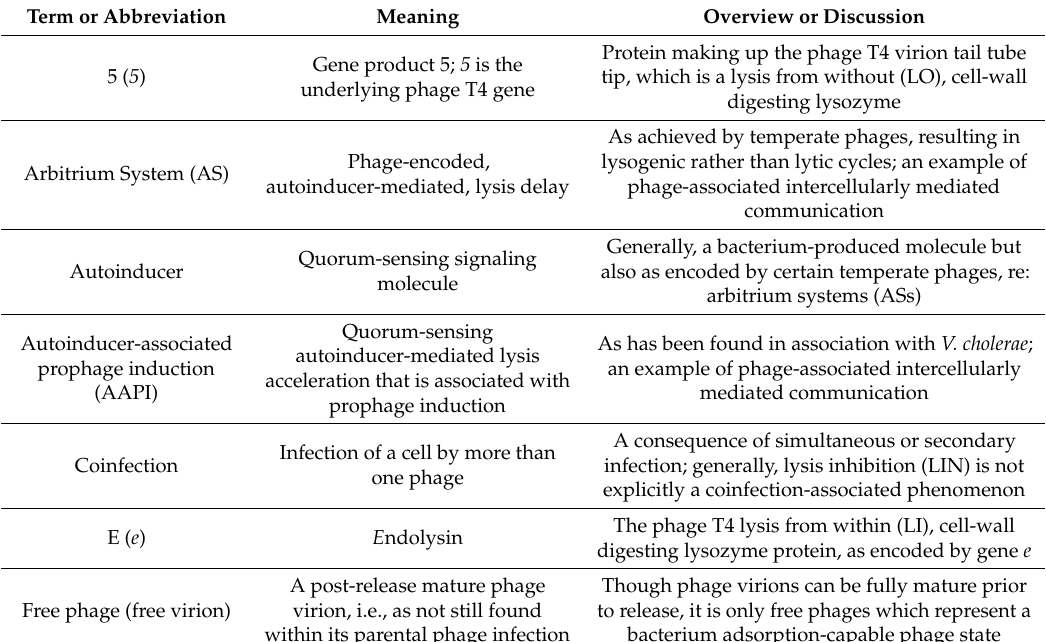
Table 2. Terms and concepts